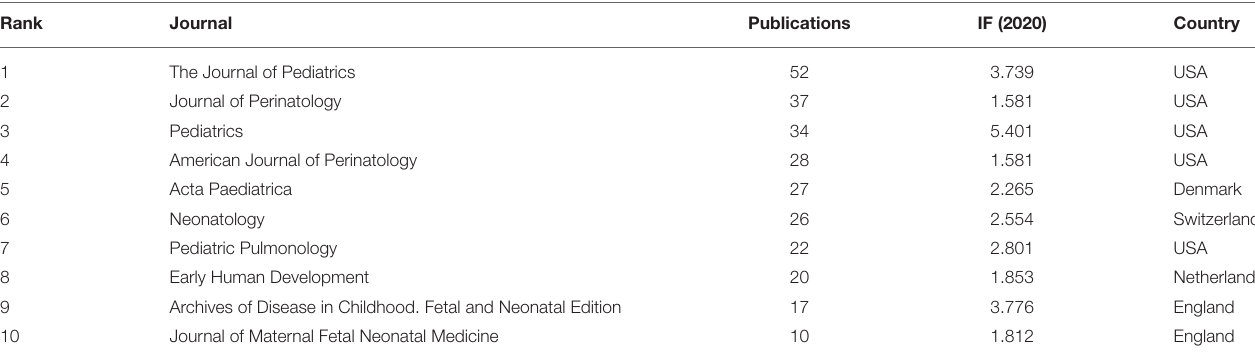
TABLE 2 | Top 10 journals and published articles on BPD in extremely pre-mature infants.